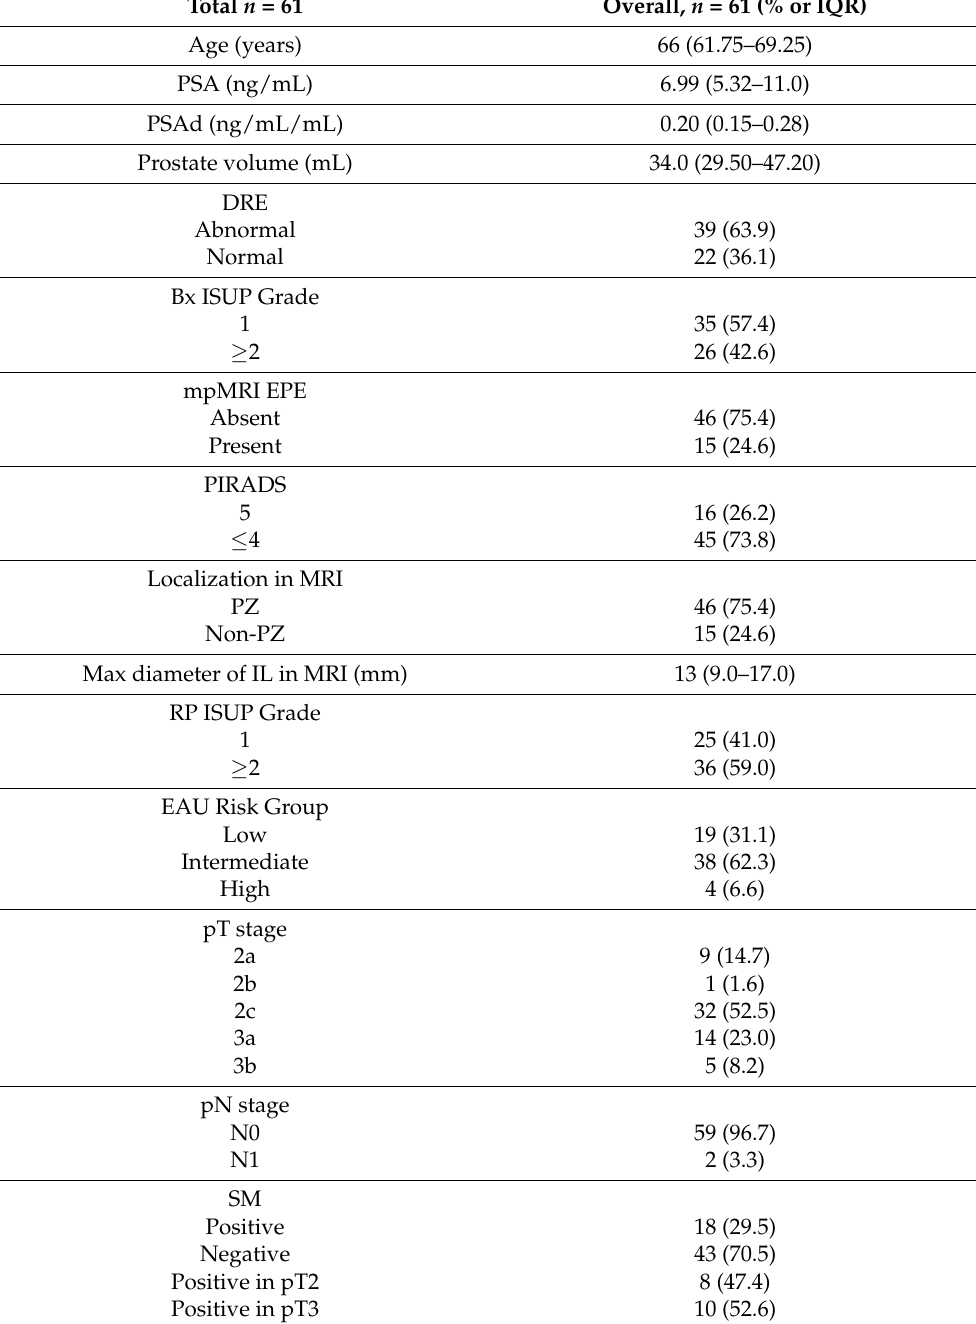
Table 1. Characteristics of the study